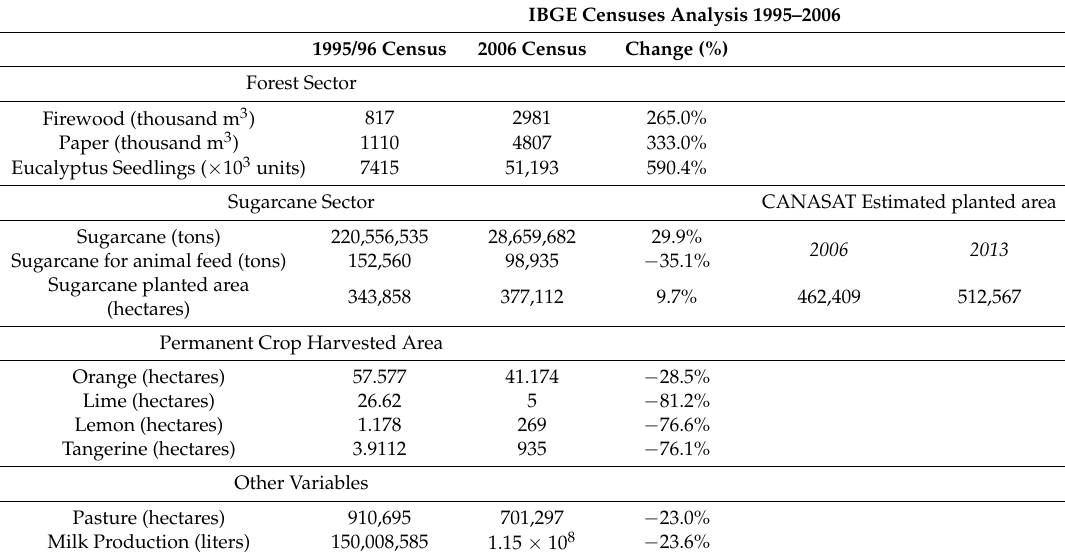
Table 5. Sugarcane and agricultural production from Census statistics and sugarcane area from the CANASAT